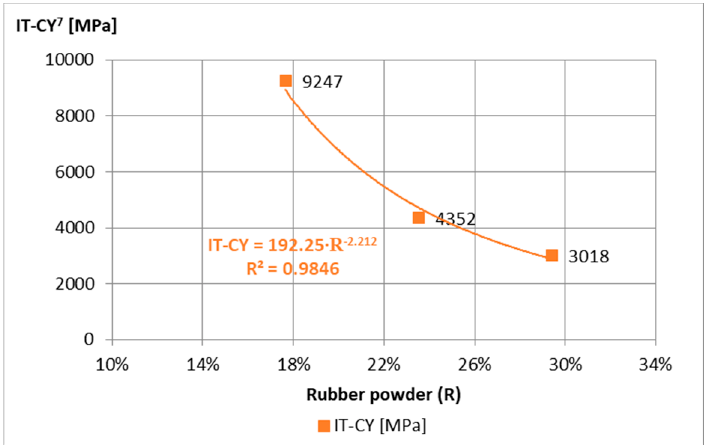
Figure 4. IT-CY stiffness modulus of mortar samples Ø100 mm × 63.5 mm depending on the amount of rubber powder, at 5 °C, after 7 days of